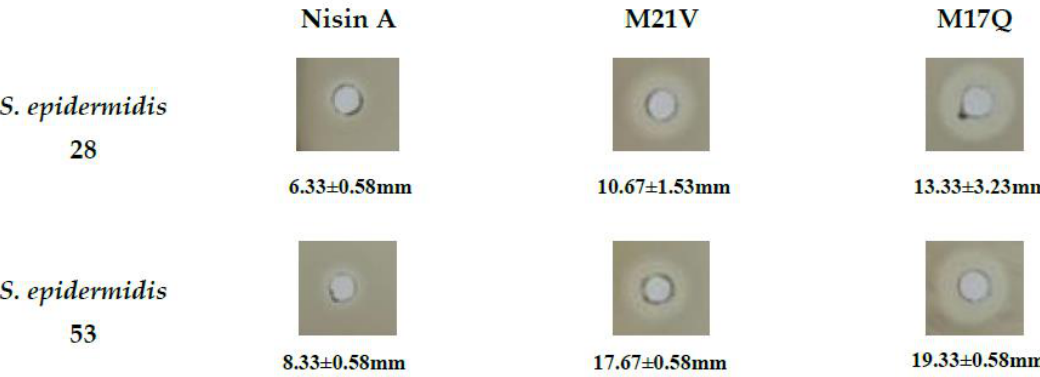
Figure 2. Images are representative of the average zones of clearing obtained when 30 µL of a 30 µM stock of each peptide was added to well in Tryptone soya agar. Plates were incubated at 37 °C overnight. Table 2. Minimum inhibitory concentration (MIC) values for wild type peptide nisin A and its derivatives M21V and M17Q against S. epidermidis . All values in the Table are µM. Nisin A M21V